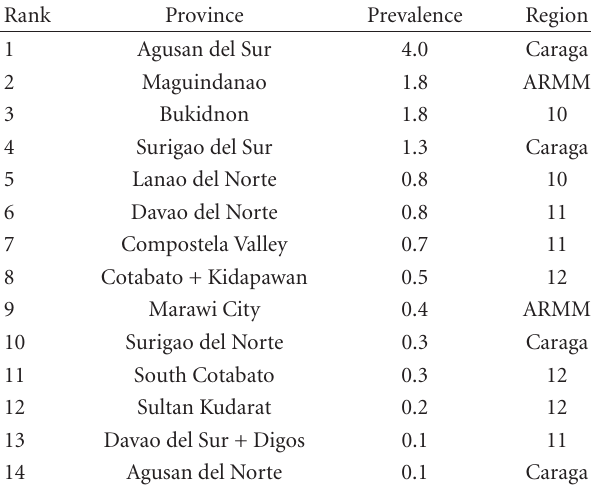
Table 3: Prevalence of schistosomiasis in endemic provinces 2005–